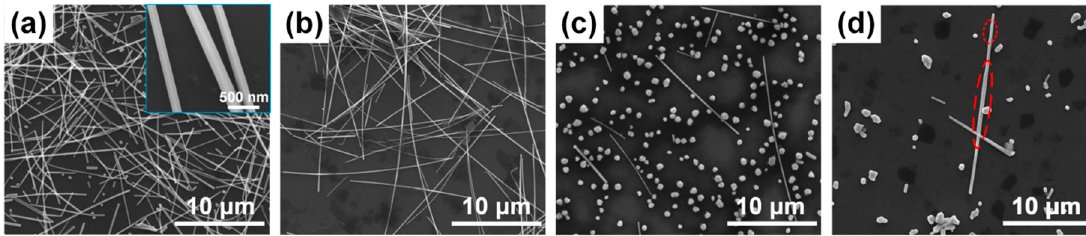
Figure 1. Scanning electron microscope (SEM) images of products synthesized with different concentrations of Fe(NO 3 ) 3 : ( a ) 0 µM, ( b ) 10 µM, ( c ) 50 µM, and ( d ) 150 µM.